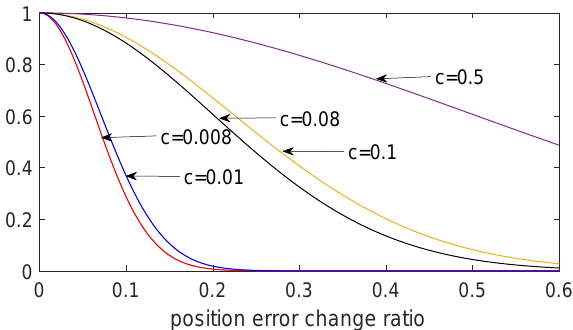
Figure 12. Curve with smoothing function under the different